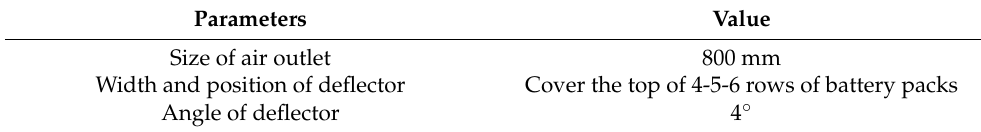
Table 7. Optimal